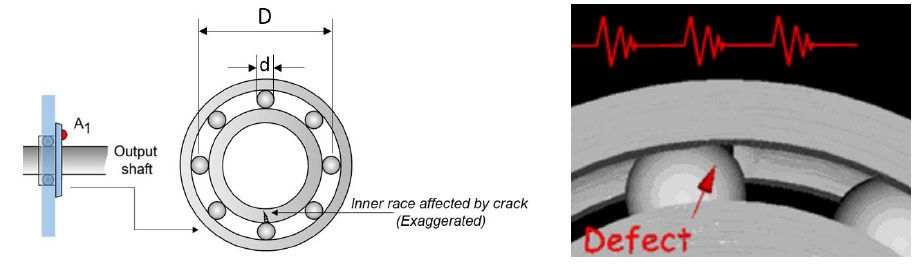
Figure 5. ( Left ) Bearing configuration with rolling elements ( left ) [21]. ( Right ) Signal expected due to bearing